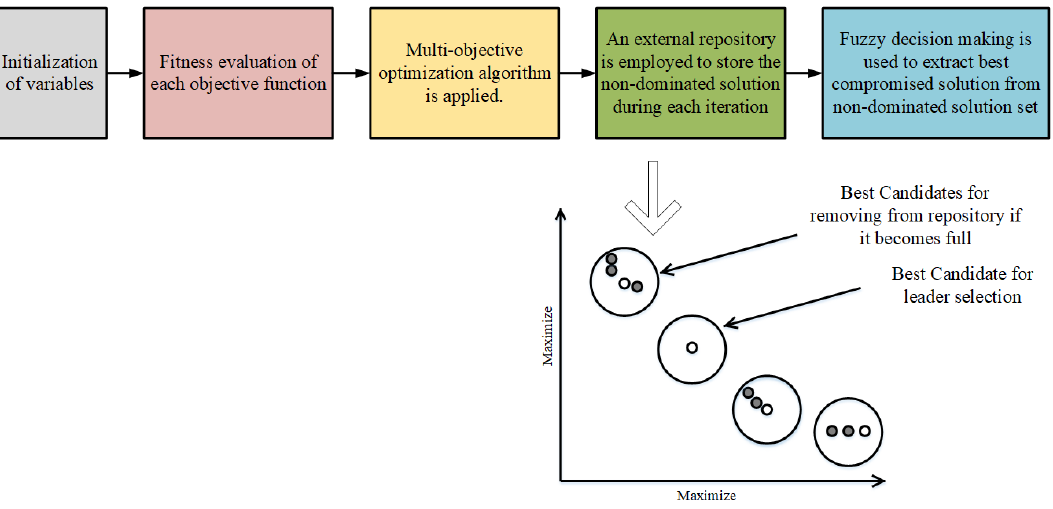
Fig. 4. Schematic representation of archive-based multiobjective optimization